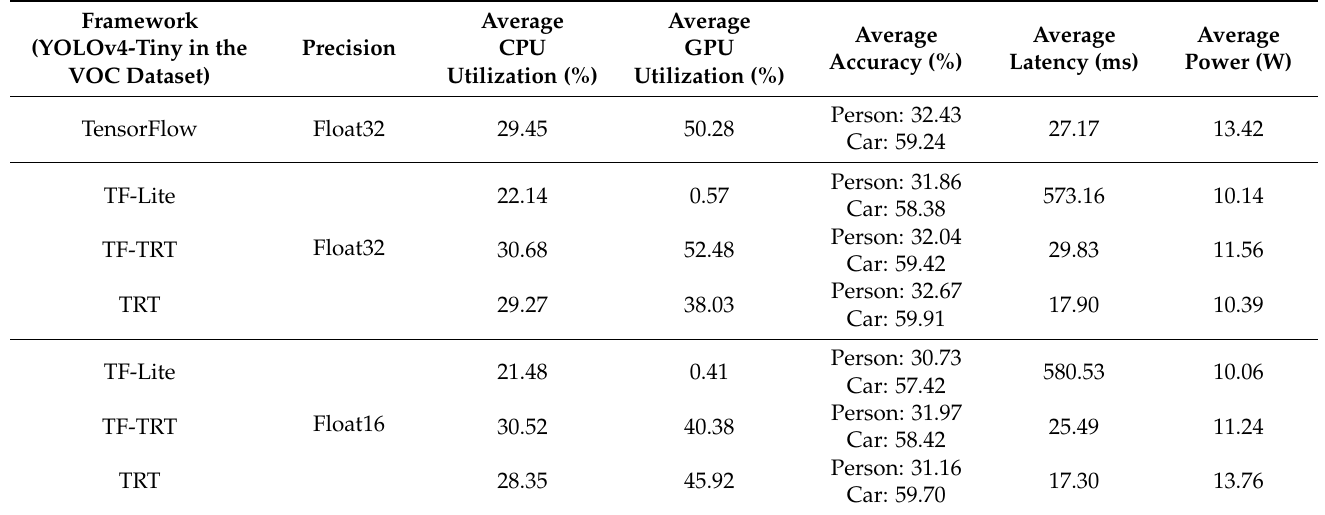
Table 5. Comparative analysis of YOLOv4-Tiny.weights’s inference performance in the PASCAL VOC